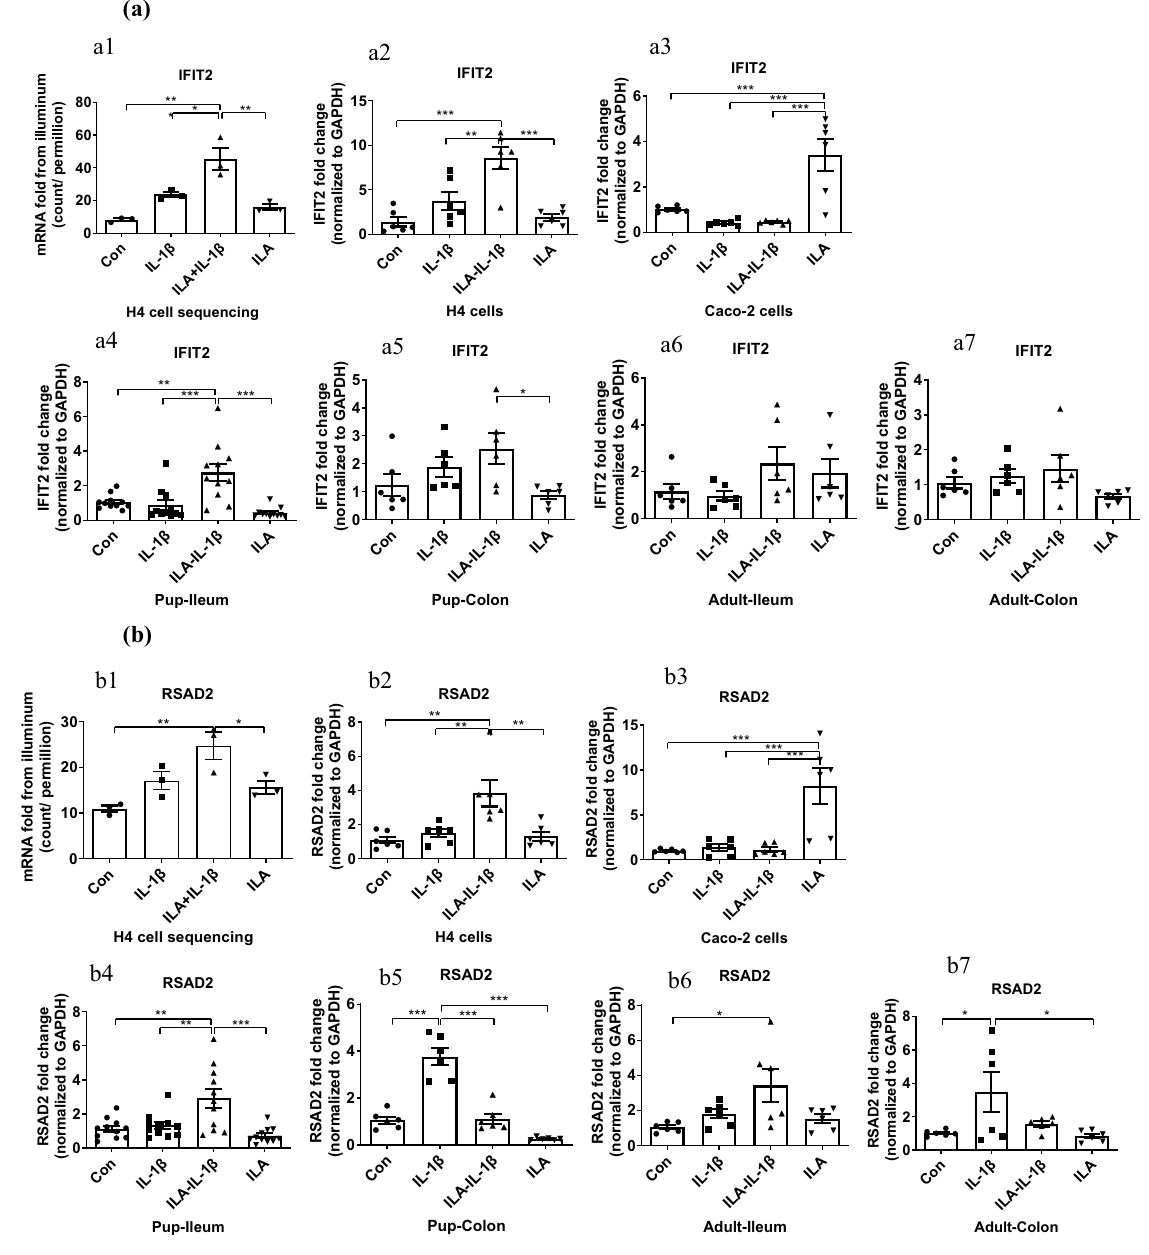
Figure 4. ILA increased anti-viral/related gene expression in immature human enterocytes and fetal mouse ileum in response to IL-1β. RNA sequencing and qRT-PCR were used. ( a ) IFIT2 and ( b ) RSAD2 mRNA sequencing analysis using Illumina (a1 and b1) and gene expression level of qRT PCR in H4 cells (a2 and b2) and Caco-2 cells (a3 and b3); in ileum (a4 and b4) and colon (a5 and b5) of pups; and ileum (a6 and b6) and colon (a7 and b7) of adults. H4 or Caco-2 cells were pretreated with ILA before IL-1β stimulation. Pup or adult mice were fed with or without ILA, whose intestinal tissues were incubated with or without IL-1β stimulation. Data are represented as the mean ± SEM (n = 3–6 for cells in repeated experiment, n = 6 for mouse). One-way ANOVA and Tukey post hoc tests were used for statistical analysis. Differences were considered significant at * p < 0.05, ** p < 0.01, *** p < 0.001. IFIT2, interferon-induced protein with tetratricopeptide repeats 2; RSAD2, radical S-adenosyl methionine domain containing